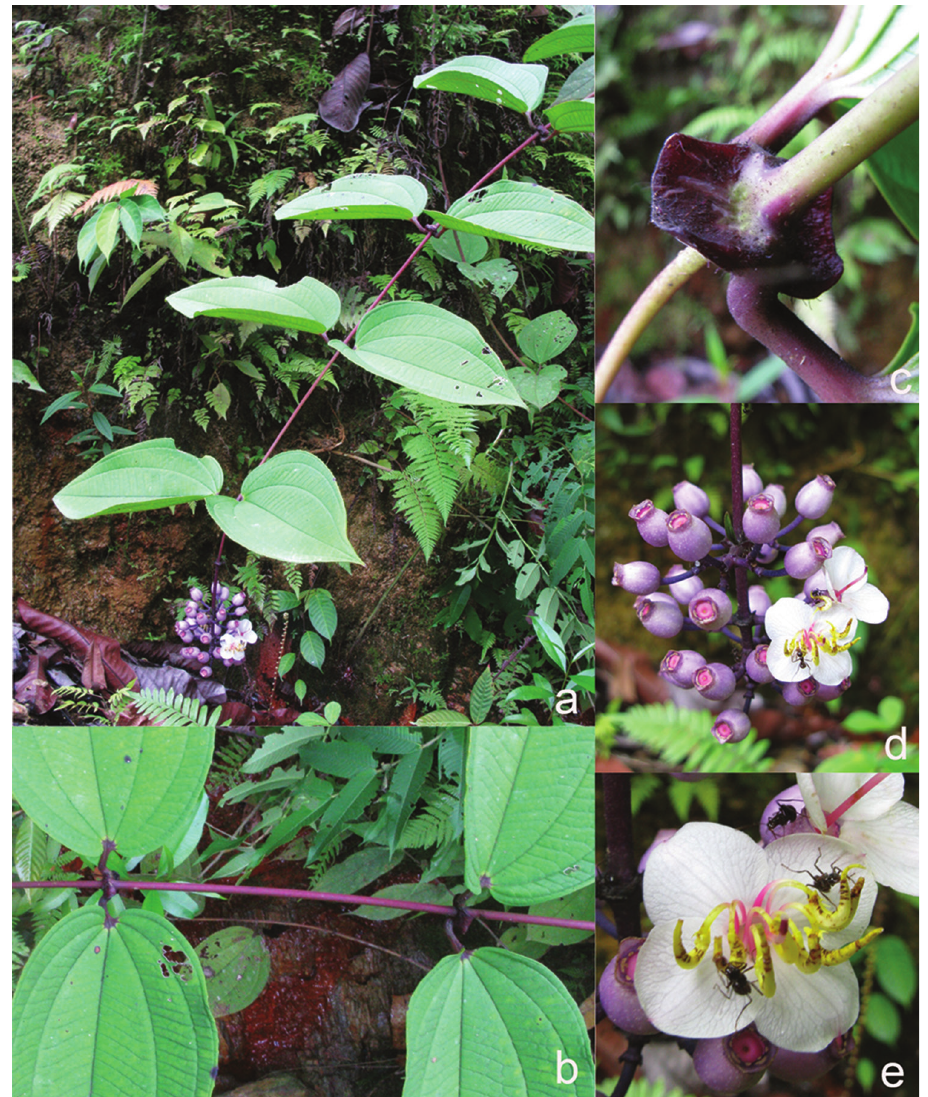
Figure 24. Dissochaeta pulchra a habit b branchlet c leaf node d infrutescence/inflorescence e flower. Photographs by J.